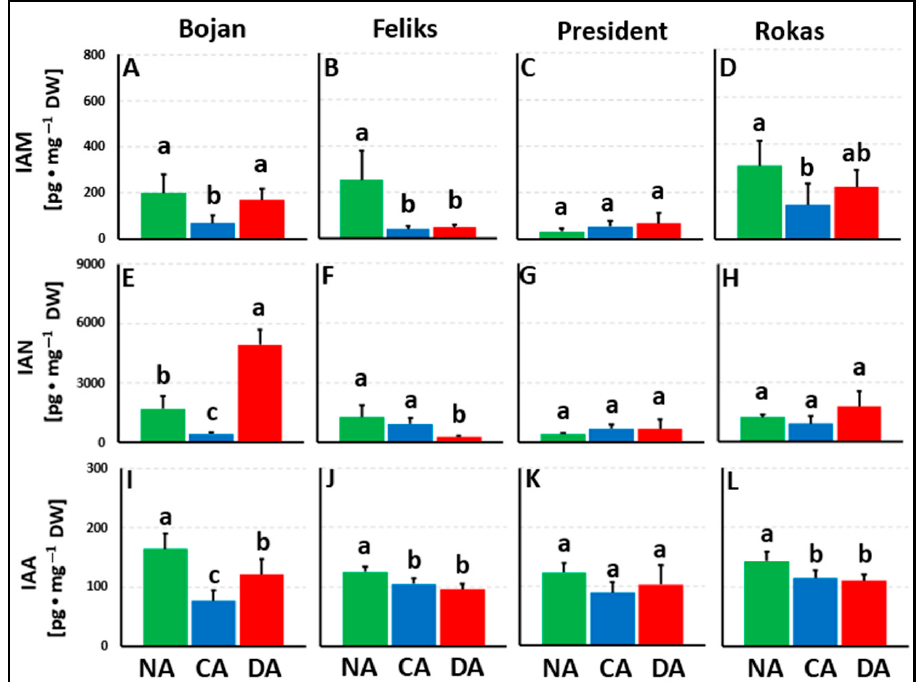
Figure 4. Content of the auxin precursors (indole-3-acetamid (IAM), indole-3-acetonitril (IAN)) and active auxin indole-3-acetic acid (IAA) in four cultivars of the non-acclimated (NA), cold-acclimated (CA) and deacclimated (DA) oilseed rape. ( A – D )—IAM; ( E – H )—IAN; ( I – L )—IAA. Values marked with the same letters (within each cultivar separately) were not significantly different according to the Duncan test ( p ≤ 0.05).